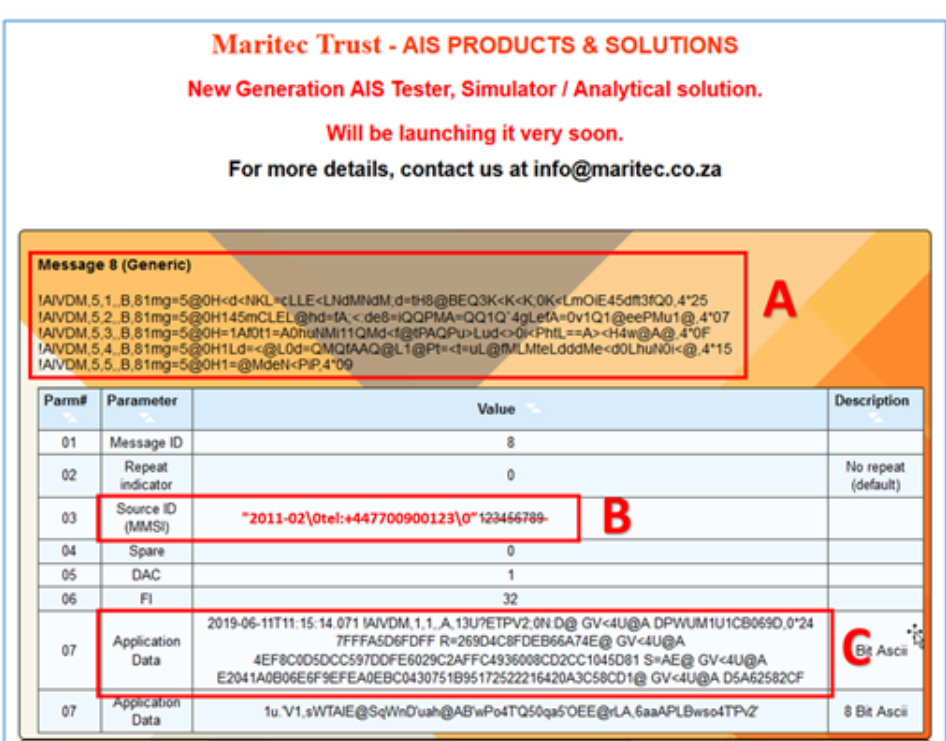
Figure 10. Original signed message ( A ); timestamp ( B ); variable cryptographic parameters of the signature ( C